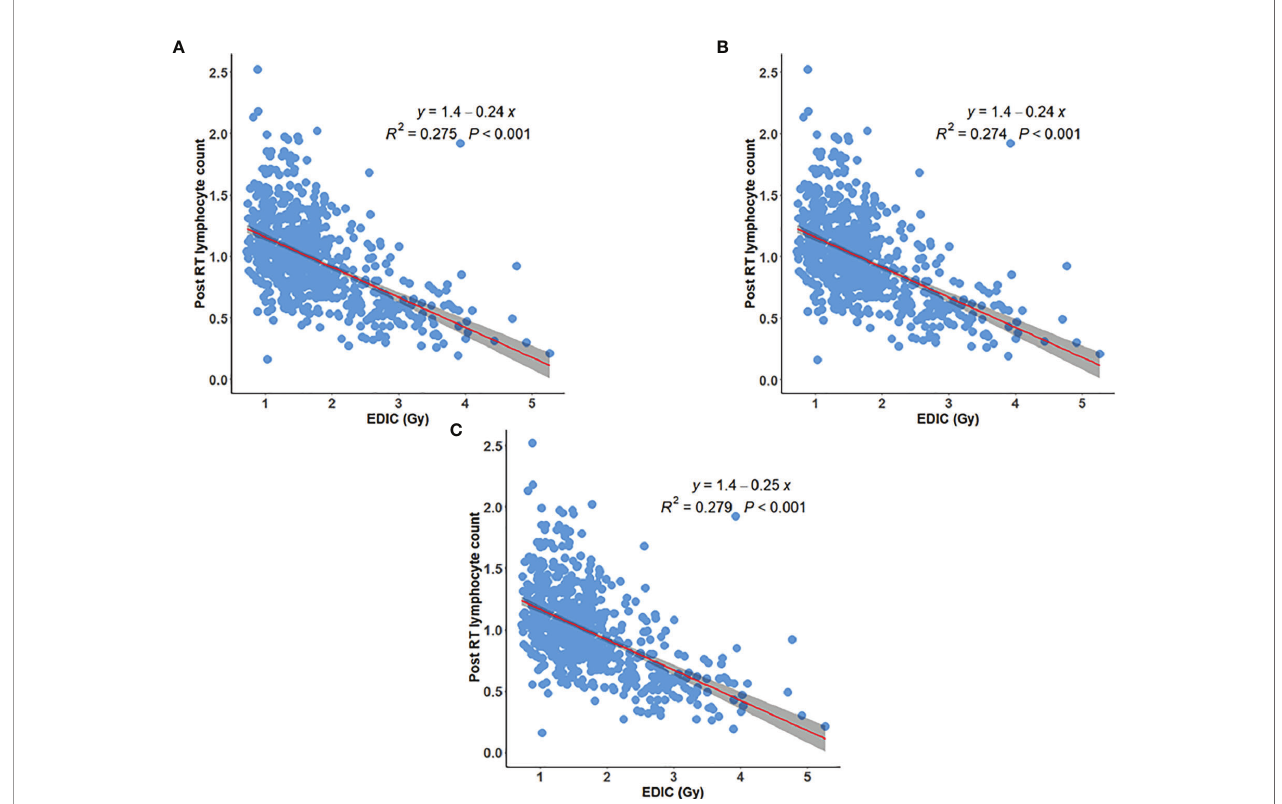
FIGURE 2 | Inverse linear relationship between EDIC and postRT peripheral lymphocyte counts (PLC) for (A) all 735 patients; (B) 732 patients excluding 3 patients with grade 3 preRT lymphopenia; (C) 714 patients excluding additional 18 patients with grade-2 preRT